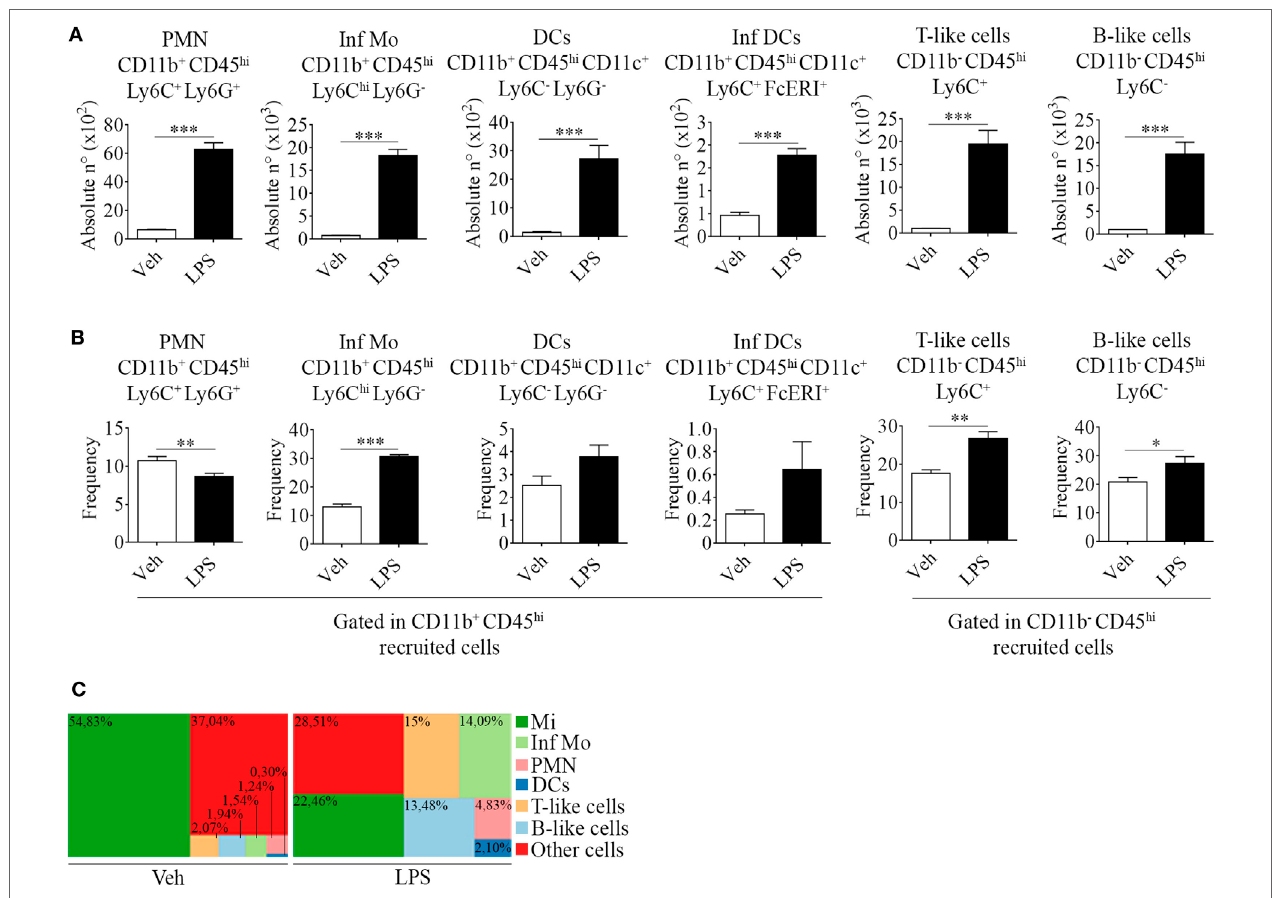
FigUre 2 | Phenotypic features of immune cells involved in neuroinflammation in the brain from endotoxemic mice. Mice were treated i.p. with either vehicle or 40 µg of lipopolysaccharide (LPS) (1,6 mg/kg) for four consecutive days to induce neuroinflammation. Twelve hours post the last injection, mice were euthanized and immune cells were isolated from whole brain homogenates and labeled for subsequent flow cytometric analysis. (a) Absolute number and (B) frequency of CD11b + CD45 hi CD11c + Ly6C − Ly6G − dendritic cells, CD11b + CD45 hi CD11c + Ly6C + Fc ϵ RI + inflammatory dendritic cells, CD11b − CD45 hi Ly6C + T-like, and CD11b + CD45 hi Ly6C − B-like lymphocytes, was assessed by flow cytometry. The percentages shown correspond to populations gated as CD11b + CD45 hi . Results are representative of at least two independent experiments ( n = 3–4 animals per group). (c) Representative hierarchical tree map comparing vehicle vs LPS frequency of resident and peripheral populations previously analyzed by flow cytometry. Results are representative of at least three independent experiments ( n = 3–4 animals per group). Data are expressed as mean ± SEM. Mi, microglial cells; Inf Mo, inflammatory monocytes; PMN, neutrophils; DCs, dendritic cells; Inf DCs, inflammatory dendritic cells; other cells, neurons, astrocytes,